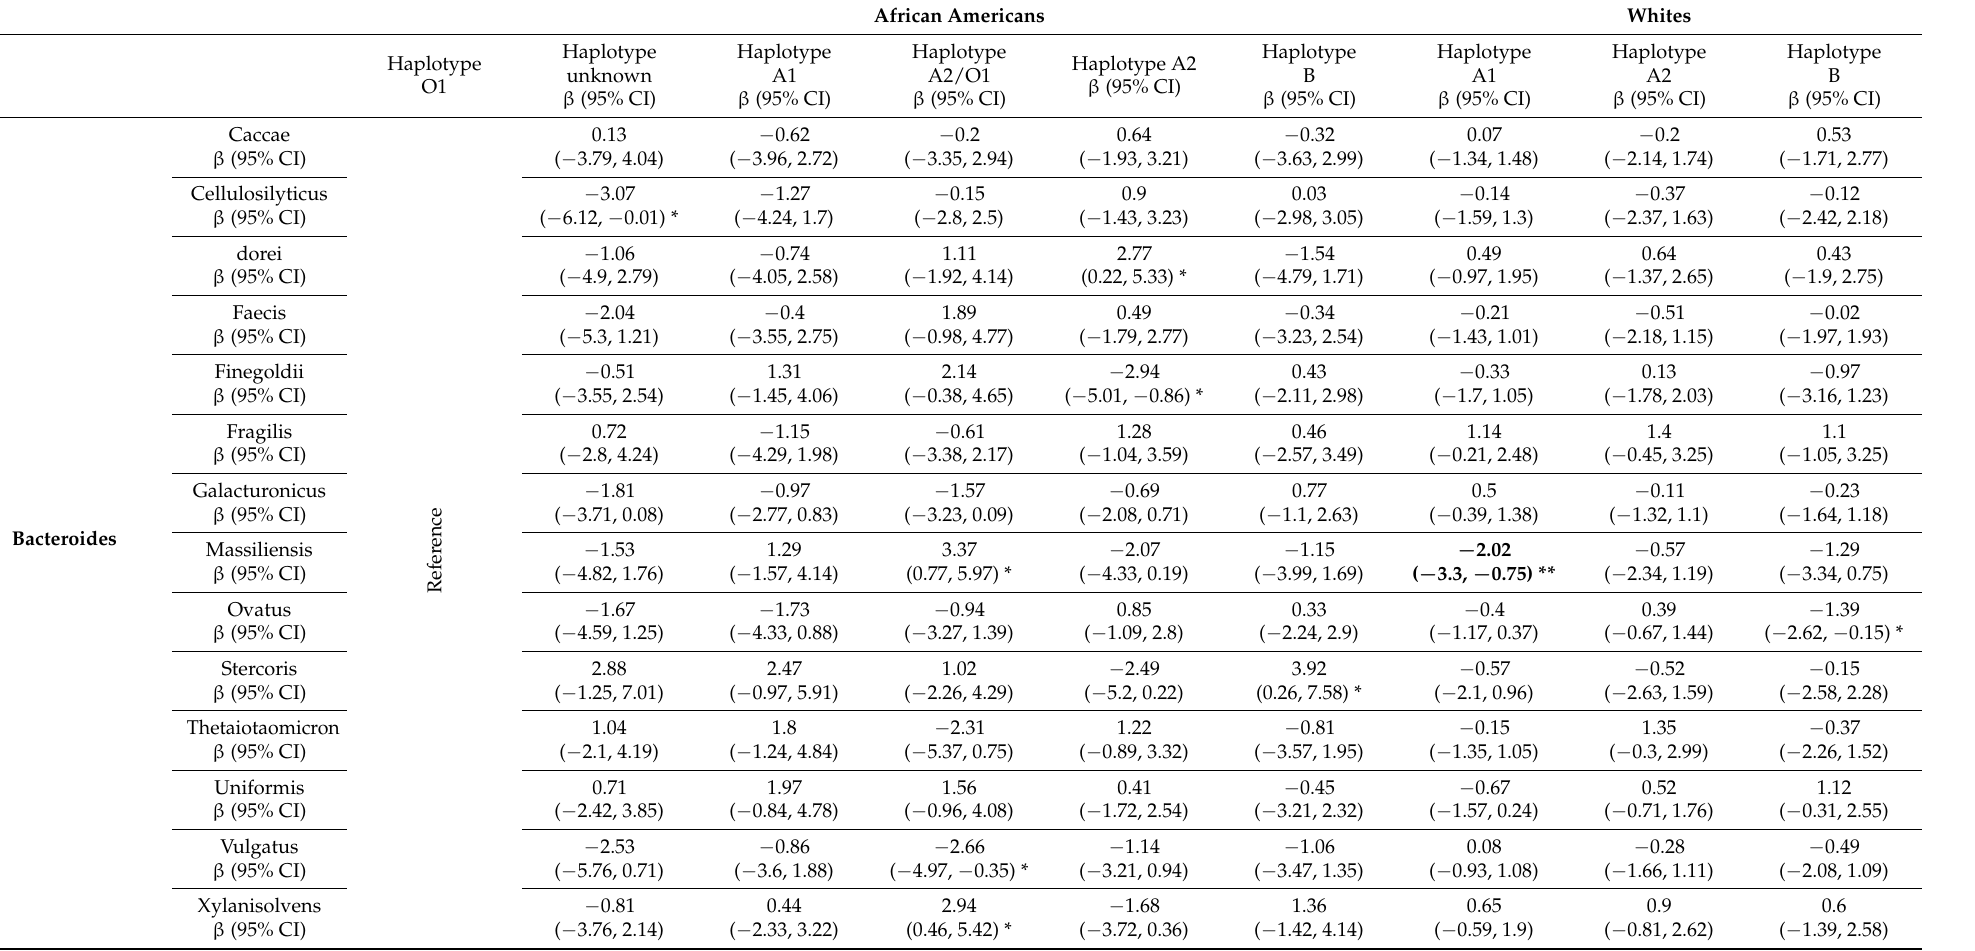
Table 3. The associations between ABO haplotypes and relative abundance of selected 21 bacterial species in the MILES study, compared to the reference group haplotype